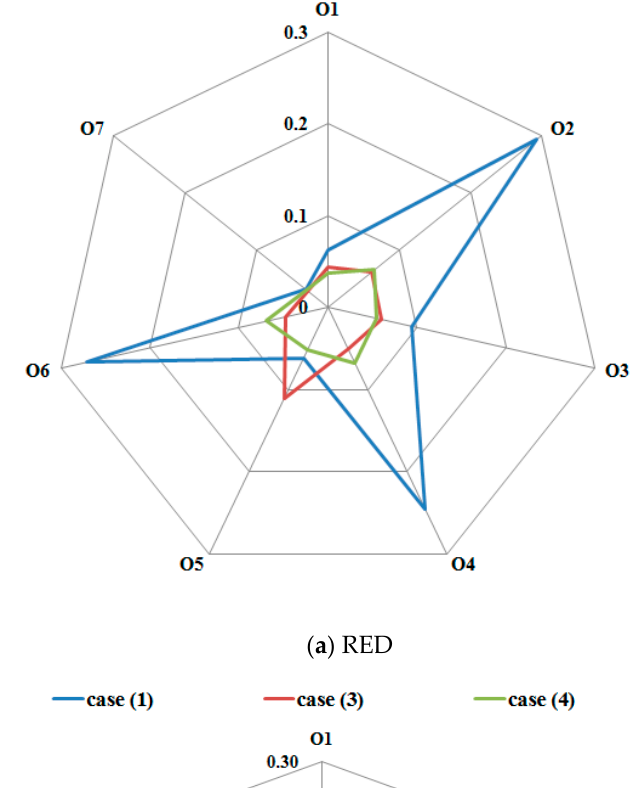
Figure 5. Between the strips in section lines 𝐺𝐻(cid:3364)(cid:3364)(cid:3364)(cid:3364),𝐾𝐿(cid:3364)(cid:3364)(cid:3364)(cid:3364), 𝑃𝑄(cid:3364)(cid:3364)(cid:3364)(cid:3364) , 𝑅𝑆(cid:3364)(cid:3364)(cid:3364)(cid:3364), 𝑇𝑈(cid:3364)(cid:3364)(cid:3364)(cid:3364), and 𝑉𝑊(cid:3364)(cid:3364)(cid:3364)(cid:3364)(cid:3364) in Cases 1, 2, 3, and 4. Different colors represent different strips. A scale of abscissa axis is 1:280.